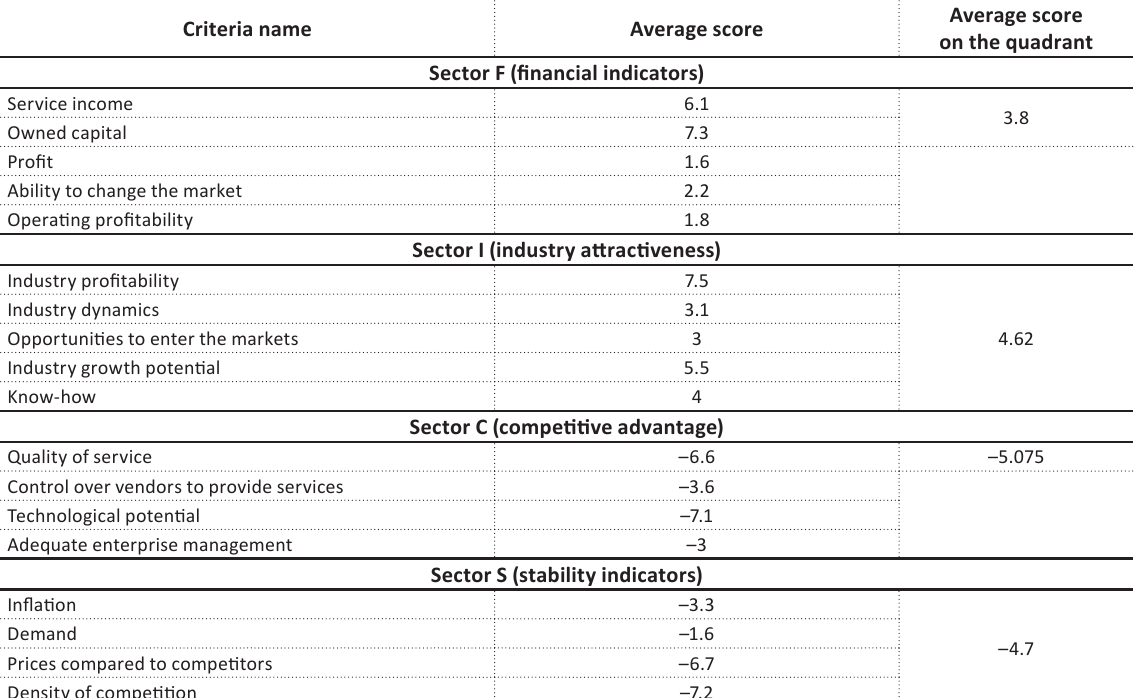
Table 7. The results of estimation of Sigma Software economic activity in the international market using the SPACE